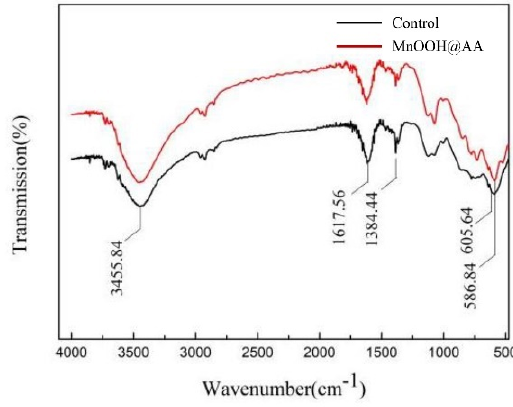
Figure 6. FTIR of AA before and after modification.